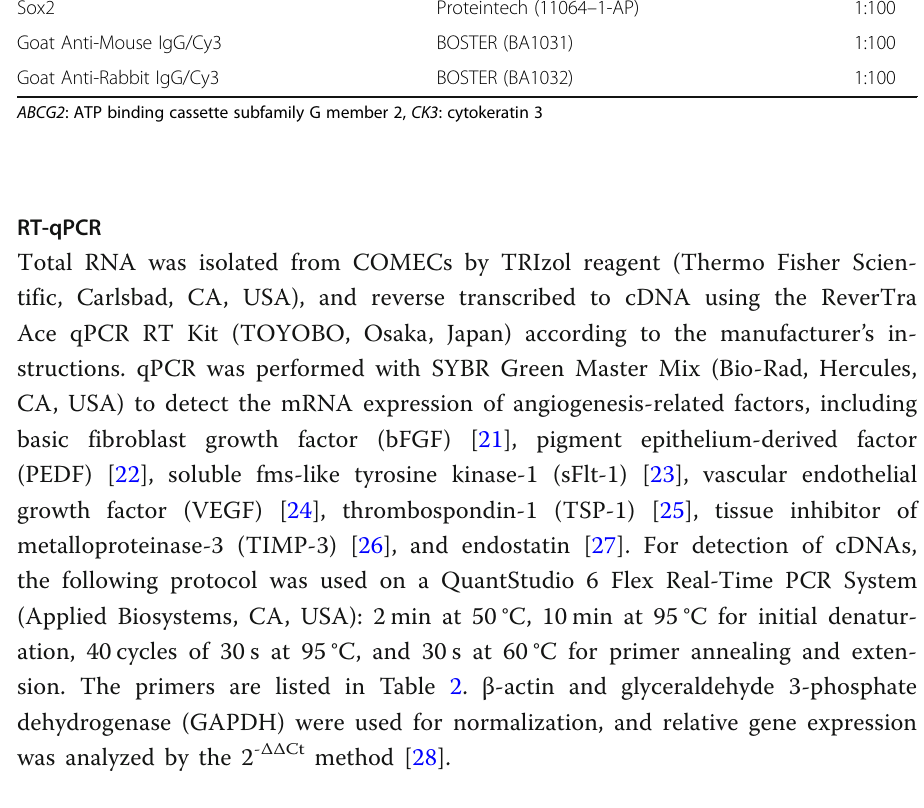
Goat Anti-Mouse IgG/Cy3 Goat Anti-Rabbit IgG/Cy3 BOSTER